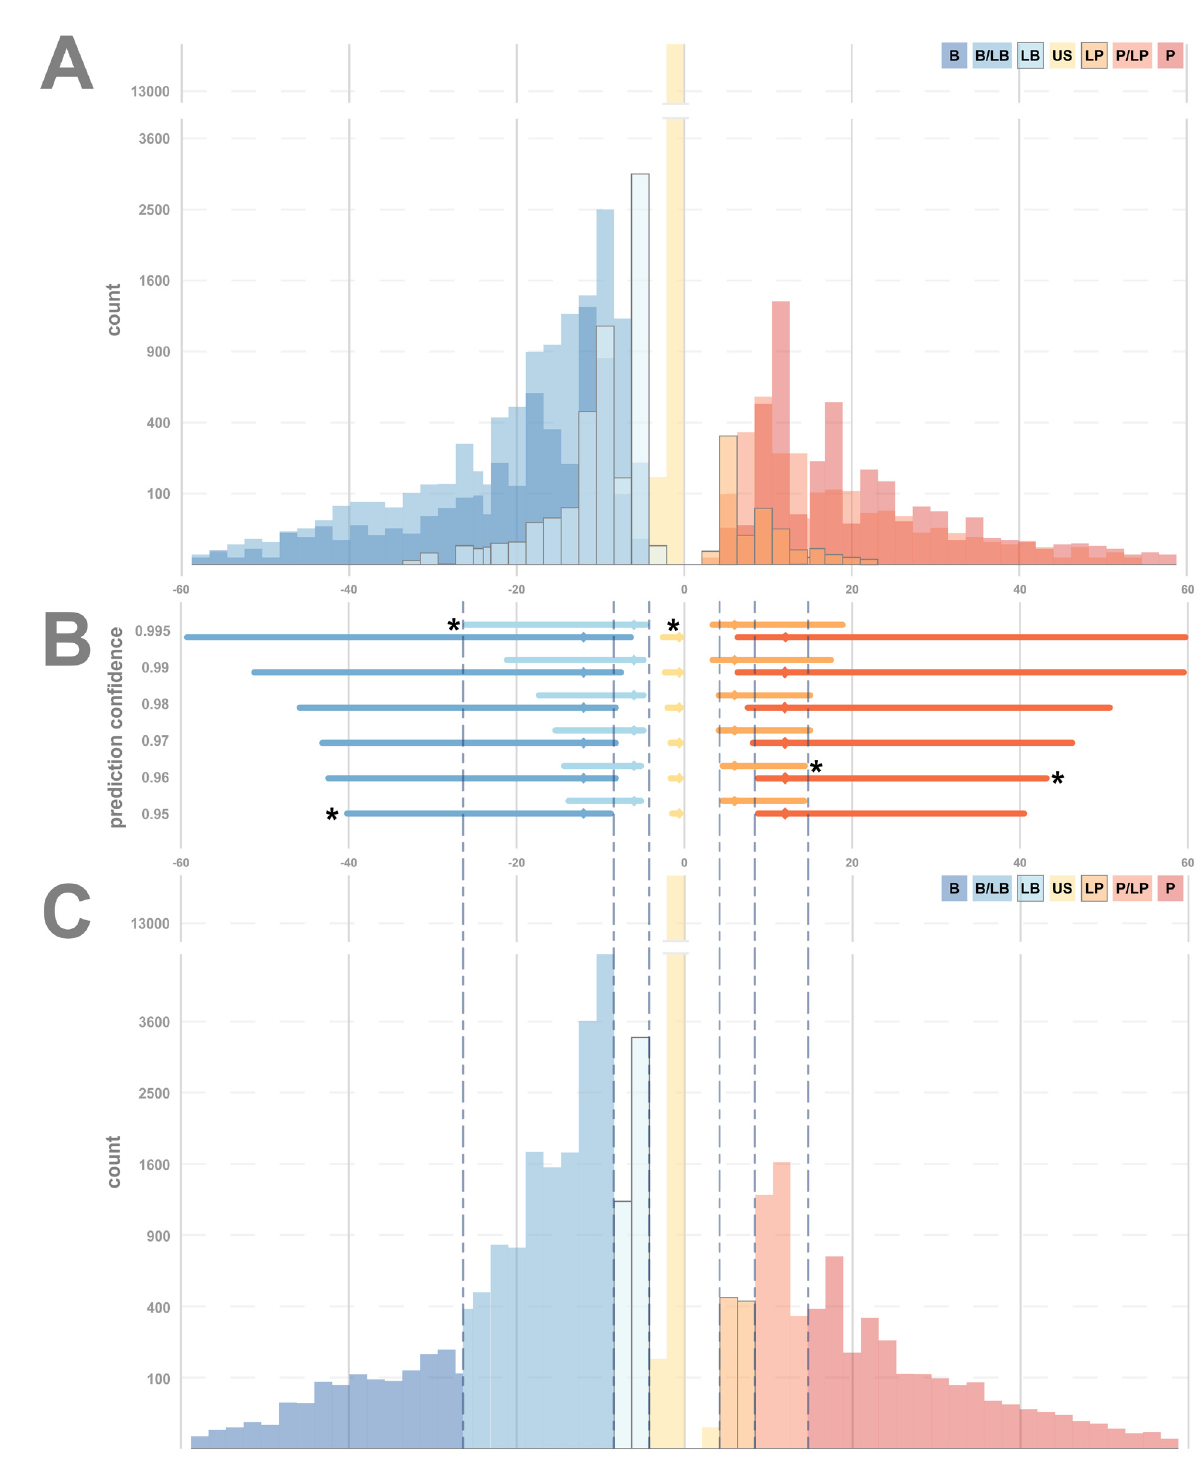
Figure 1. Clinotator raw score (CTRS) distribution of two-star ClinVar variants. ( A ) All two-star variants, plotted according to CTRS, and colored based on the seven ClinVar clinical significance designations: Benign (B), Benign/Likely benign (BLB), Likely benign (LB), Uncertain Significance (US), Likely pathogenic (LP) Pathogenic/Likely pathogenic (PLP) and Pathogenic (P). ( B ) Prediction intervals (PI) for the five primary Mendelian clinical significances (B, LB, US, LP and P). Intervals plotted by CTRS value, using five different interval confidences (vertical axis). The optimal confidence interval for each clinical significance is marked with an asterisk. ( C ) All two-star variants plotted according to Clinotator Raw Score, and colored based on the seven Clinotator predicted significance ranges (B, BLB, LB, US, LP, PLP and P) after calibration with prediction intervals. Dashed lines denote prediction interval boundaries from ( B